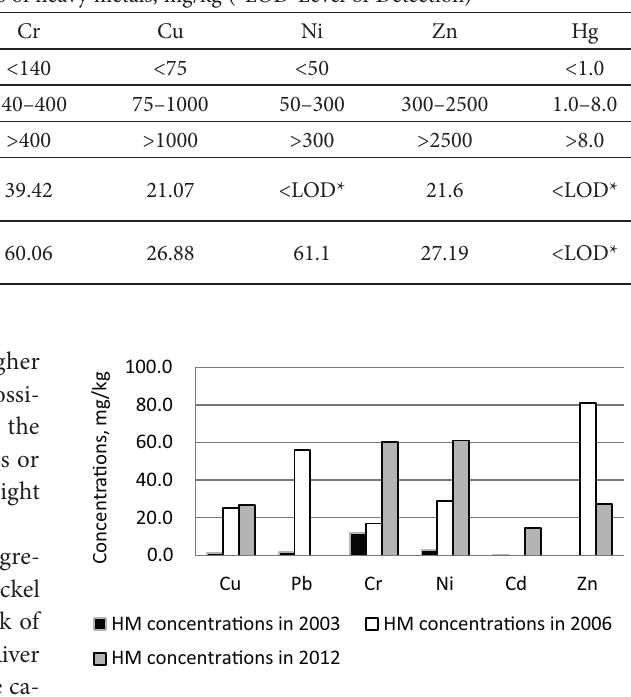
Fig. 5. HM concentrations in Nemunas River bottom sediments